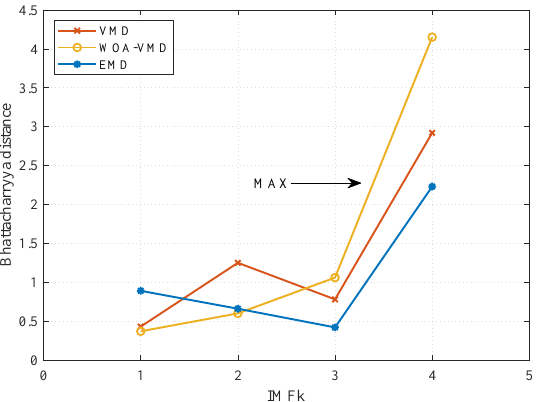
Figure 7. Improved Bhattacharyya distance between IMFs and mixed signal. The SNR of the mixed signal is 18.56 dB. After processing by the VMD method, WOA-VMD-BD method, and EMD method, the SNR of the recombined signal is 22.46 dB, 24.63 dB, and 21.39 dB, respectively. The denoising effect of the WOA-VMD-BD method is more accurate than the other two methods. The WOA-VMD-BD method can